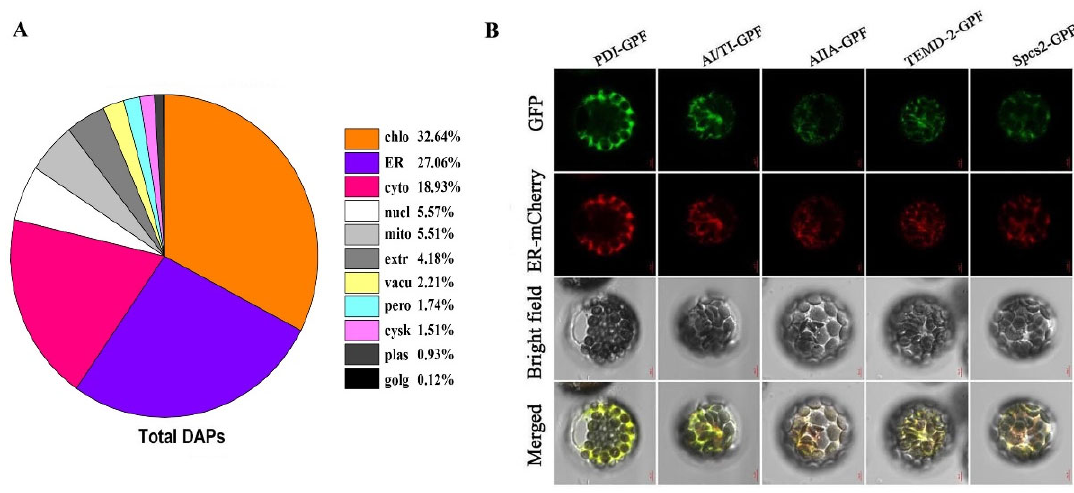
Figure 3. Subcellular localization of the proteins identified in wheat ER proteome under salt stresses. ( A ) Subcellular localization prediction of total proteins identified in the wheat endoplasmic reticulum. Chlo, chloroplast; ER, endoplasmic reticulum; Cyto, cytoplasm; Nucl, nucleus; Mito, mitochondria; Pero, peroxisome; Plas, plasma membrane; Extr, extracellular; Cysk, cytoskeleton; Vacu, vacuole. ( B ) Subcellular localization assay of five reprehensive proteins by wheat protoplast transformation. GFP, green fluorescent protein; ER-cherry; bright field, the field of bright light; merged, merged GFP fluorescence; ER-cherry, and the field of bright light; 16,318, empty vector; PDI: protein disulfide-isomerase; AI/TI: alpha-amylase/trypsin inhibitor; AIIA: probable ureidoglycolate hydrolase; TMED2:GOLD domain-containing protein; Spcs2: probable signal peptidase complex subunit 2; bar = 5 μ m.